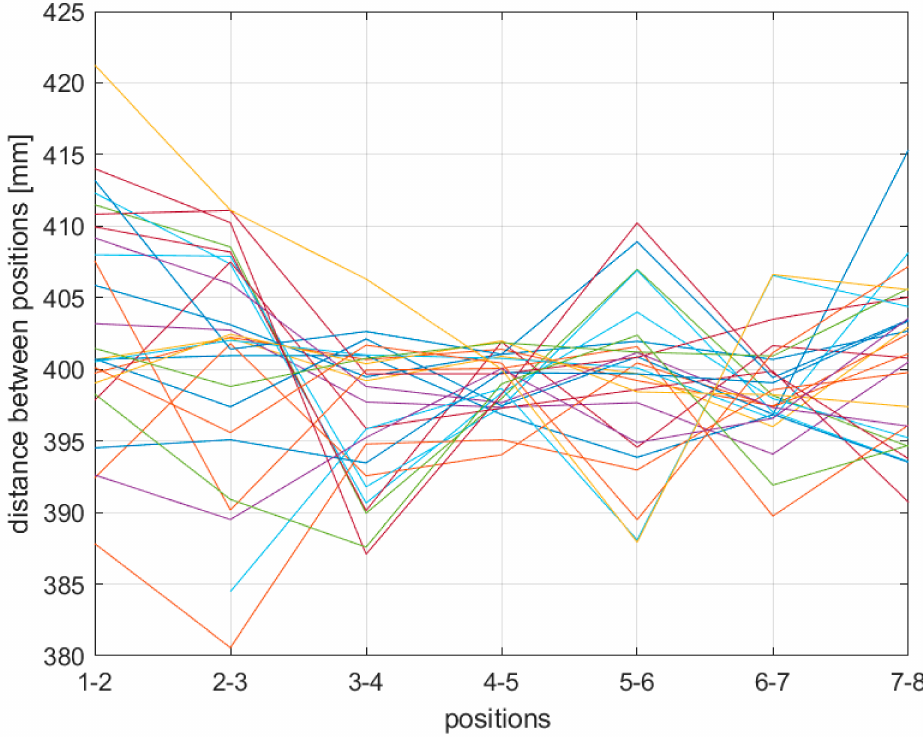
Figure 16. Body joint relative measurements of Azure Kinect in the NFOV